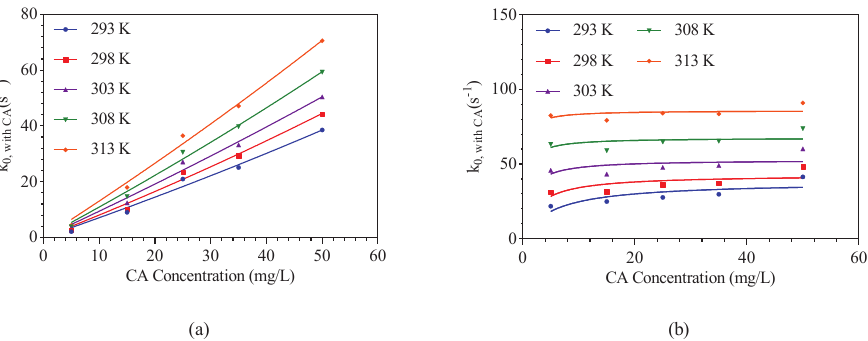
Figure 6. The changed k 0, amine value of CO of carbonic anhydrase in the amine-CA-CO represents the TEA-CA-CO